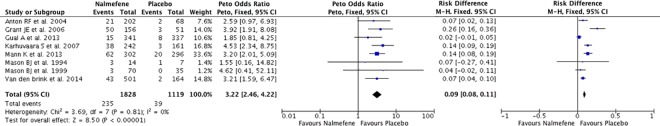
Withdrawals due to adverse events of nalmefene compared to placebo in patients with substance use or/and impulse control.